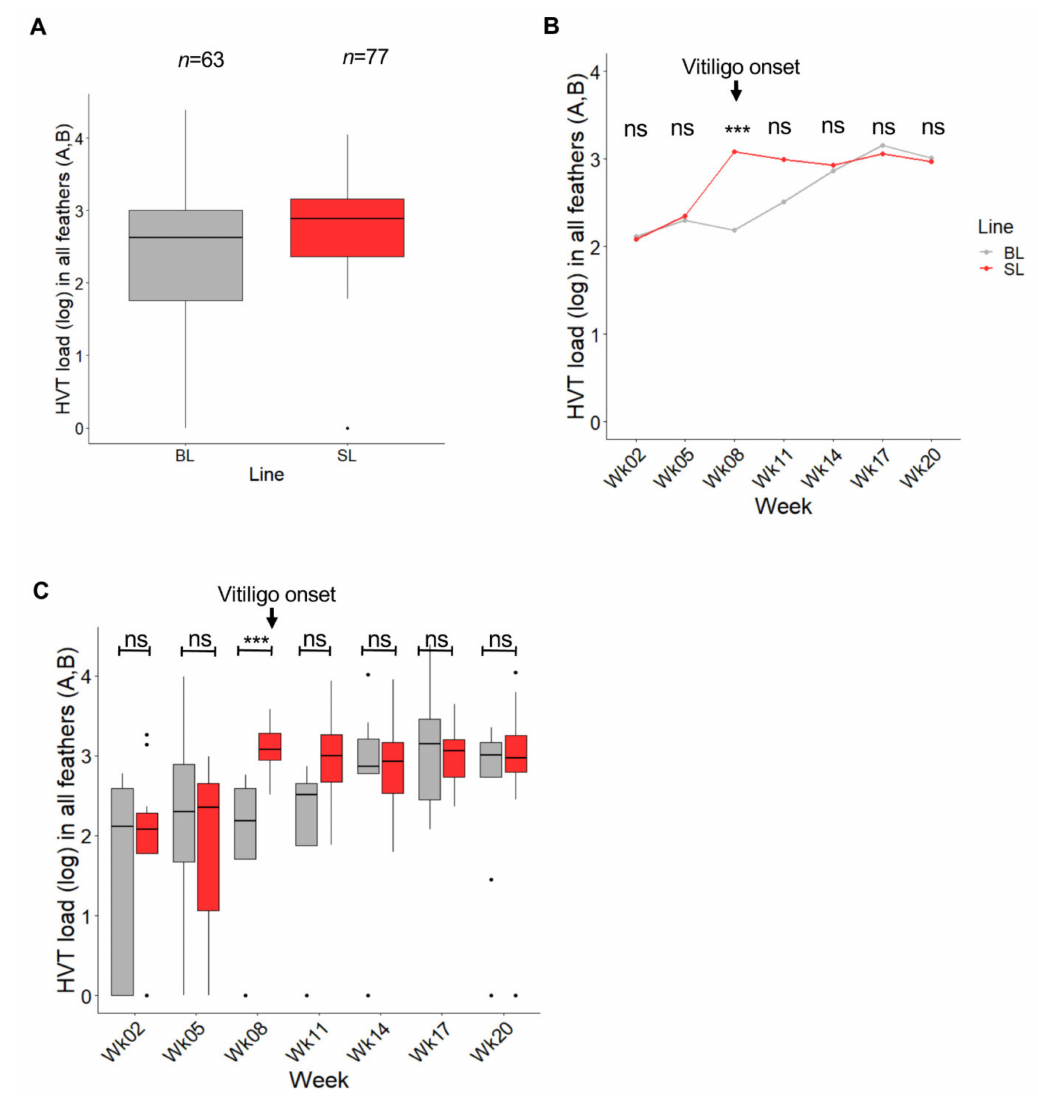
Figure 2. Influence of the chicken line (BL vs. SL) on HVT load in feathers independent of pigmentation. Data are shown in gray for BL and in red for SL. Feathers of all types were considered herein (pigmented or not) and abbreviated feathers ( A , B ). The HVT load unit is HVT genome copy number per million cells. ( A ) HVT load across time. Data are shown in Tukey boxes with the log medians visible as thick horizontal bars (2.629 for BL, 2.889 for SL). The HVT loads were moderate in both lines. ( B ) Dynamic of HVT load over time. Each dot corresponds to the median load (log) at a time point. The di ff erence in HVT load was significant at week 8 (adjusted p -value < 0.001, ***; Wilcoxon test with a Holm correction for multiple comparison). ns, non-significant. ( C ) HVT load per line over time. Data are shown in Tukey boxes as above. ns,